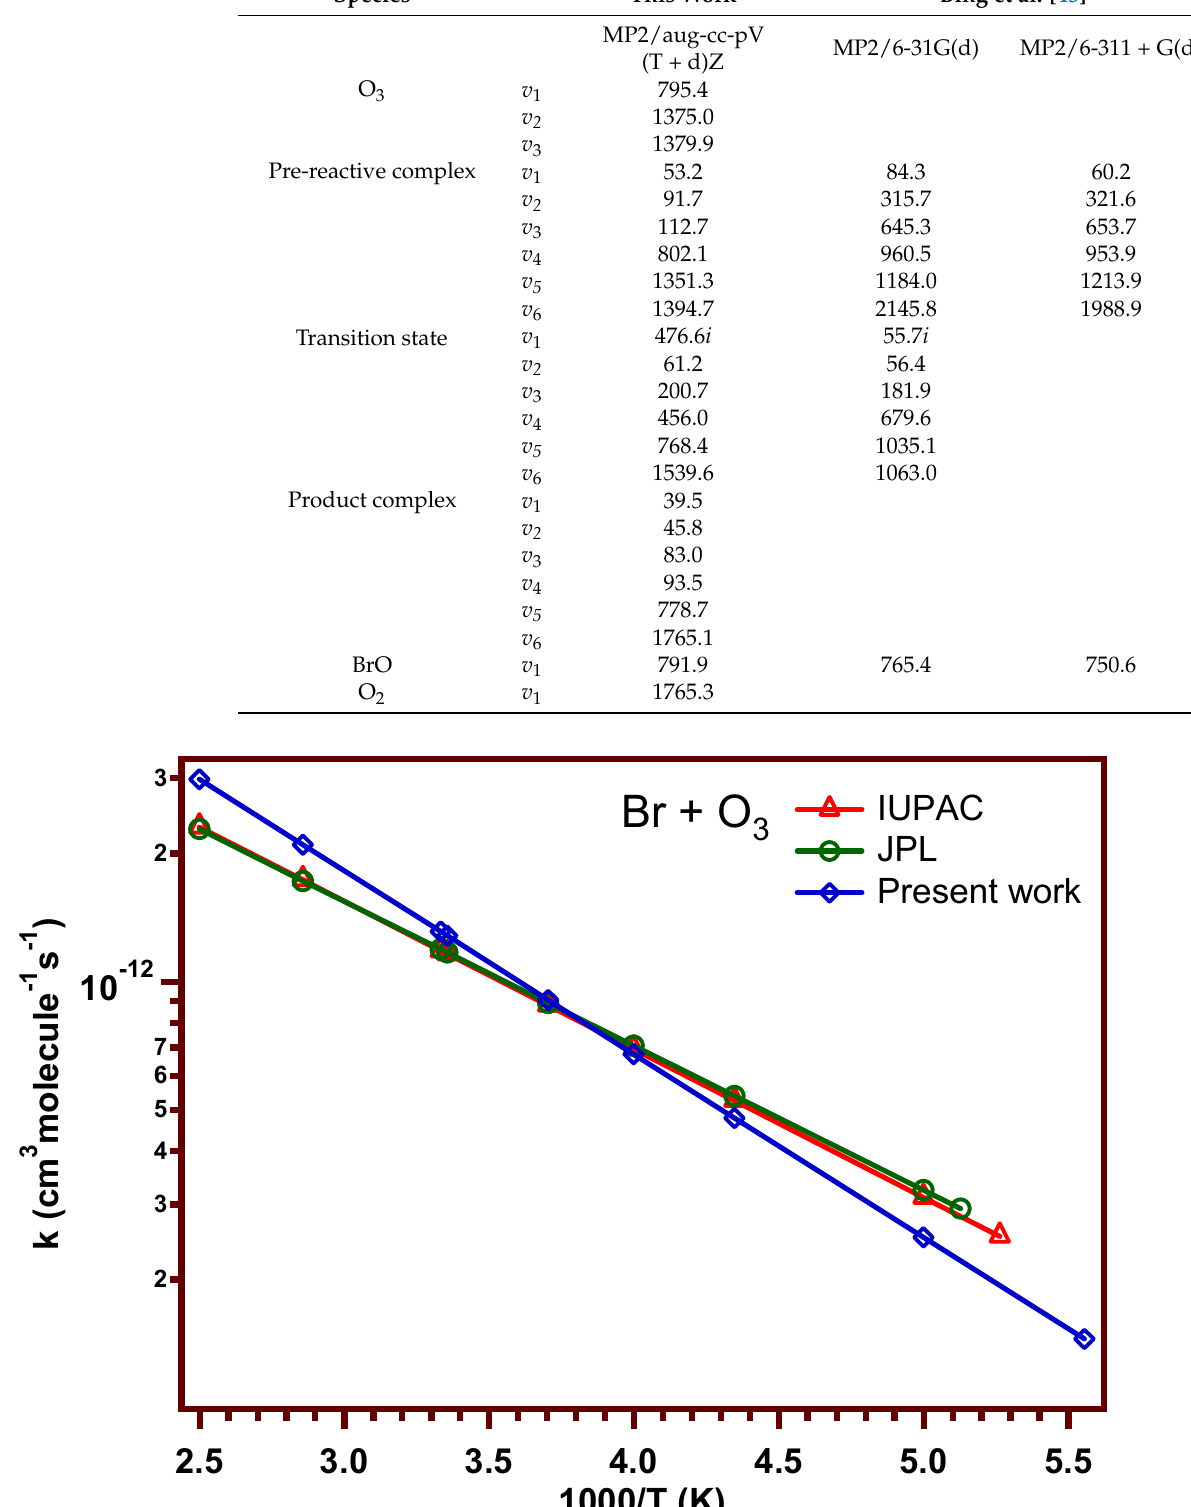
Table 5. Vibrational frequencies (cm − 1 ) for the reaction of Br + O 3 at various levels of theory. Species